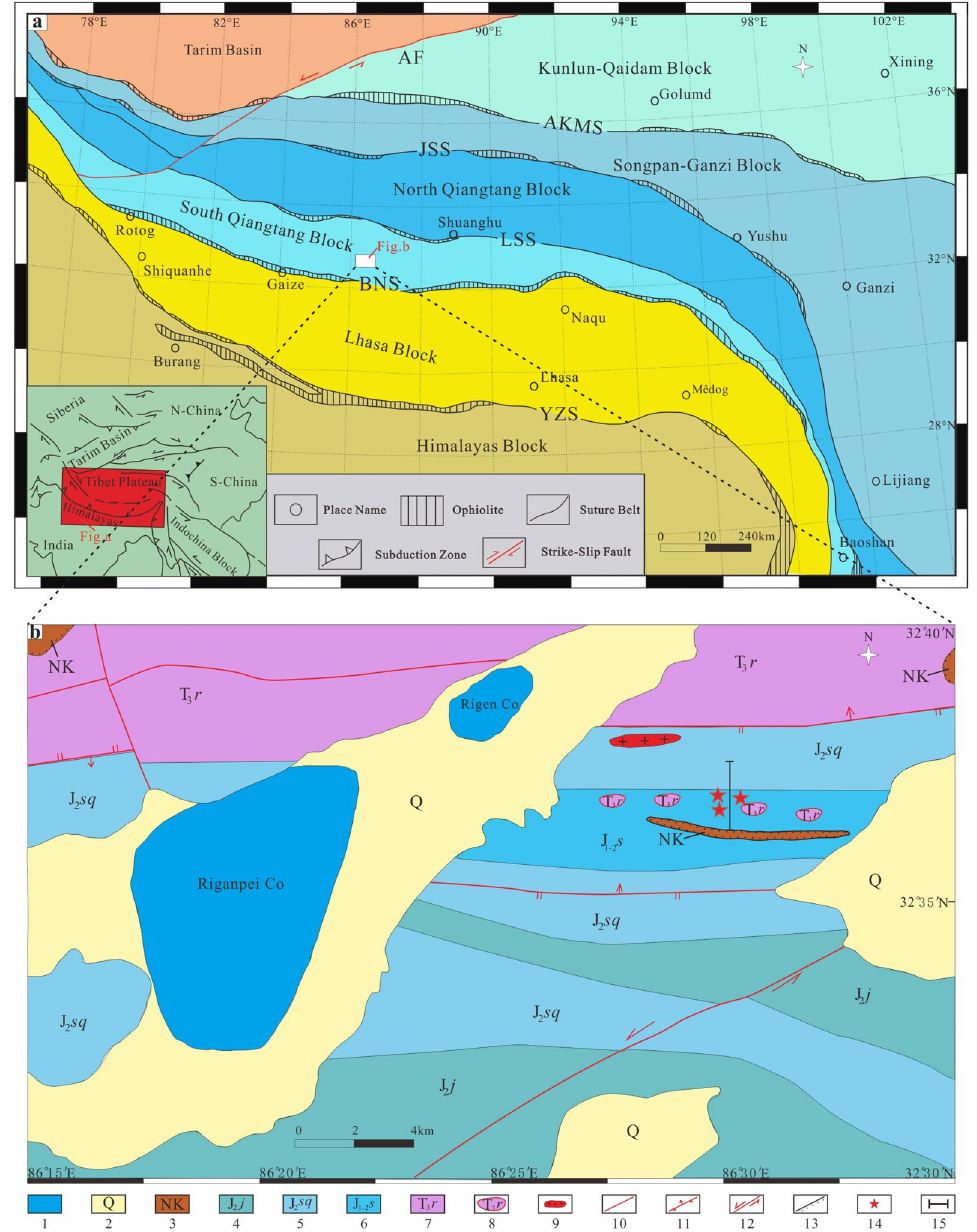
Figure 1. ( a ) Tectonic outline of the Himalaya-Tibetan Plateau showing major terranes and suture zones 15 . ( b ) Geological map of the study area showing the Rigenco section and sample locations 82 . YZS, Yarlung-Zangbo suture zone; BNS, Bangong-Nujiang suture zone; LSS, Lungmu Co-Shuanghu suture zone; JSS, Jinsha suture zone; AKMS, Ayimaqin-Kunlun-Mutztagh suture zone; AF, Arkin Fracture zone; 1, Lake; 2, Quaternary strata; 3, Neogene Kangtog Formation; 4, Middle Jurassic Jiebuqu Formation; 5, Middle Jurassic Shaqiaomu Formation; 6, Lower-Middle Jurassic Sêwa Formation; 7, Upper Triassic Riganpeicuo Formation; 8, Olistostromes; 9, Granite Porphyry; 10, Fault; 11, Reverse Fault; 12, Strike Slip Fault; 13, Angular unconformity; 14, Sampling Points; 15, Location of